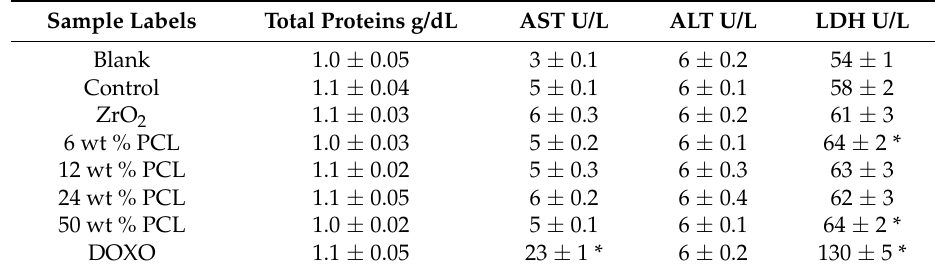
Table 1. Effects of pure ZrO 2 material, PCL/ZrO 2 hybrid materials with different percentages (6 wt %, 12 wt %, 24 wt %, 50 wt %) of PCL, and doxorubicin on the release of AST, ALT, LDH intracellular enzymatic activities. NIH-3T3 cells were cultured in the absence (control) or presence of the indicated substances for 72 h. Then, the medium from cultured cells plates and “blank” plates was collected and tested for the indicated parameters. Values are means ± S.D. of triplicate samples of a typical experiment. *, p < 0.05 hybrids vs. PCL-free ZrO 2 treated-cells and Doxo vs. control. Sample Labels Total Proteins g/dL AST